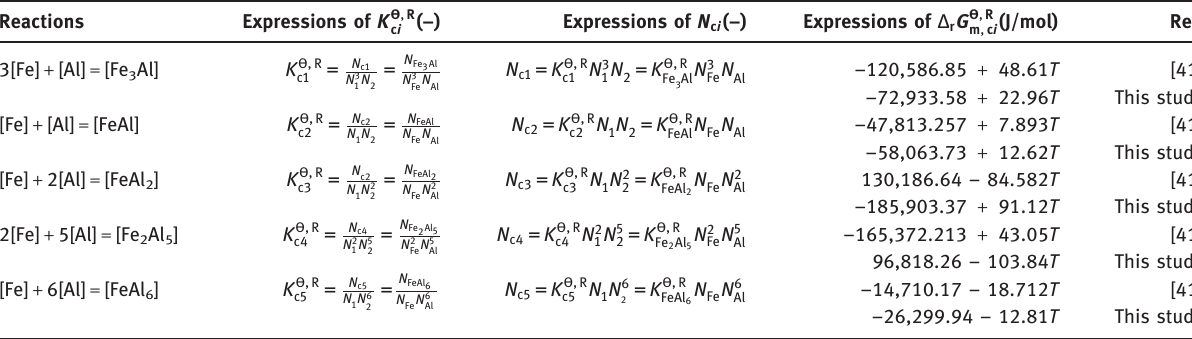
Table 4: Chemical reaction formulae of possibly formed molecules or compounds as Fe 3 Al, FeAl, FeAl 2 , Fe 2 Al 5 , and FeAl 6 , their standard equilibrium constants K Θ ,R , and mass action concentrations N c i relative to pure liquid matters as standard states, and regressed c i expressions of standard molar Gibbs free energy changes Δ r G Θ ,R of reactions for forming five associated molecules in Fe – Al binary melts m,c i over a temperature range from 1673 to 1873 K (1400 to 1600°C) based on the